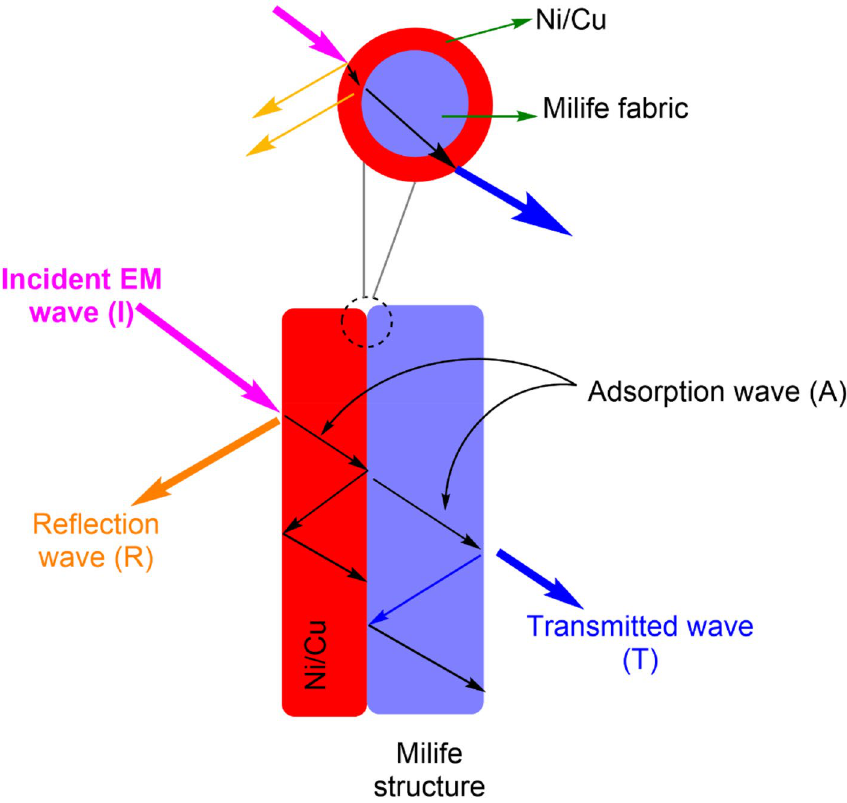
Figure 4. Schematic representation of Ni/Cu coated fibrous materials under EM atmosphere.